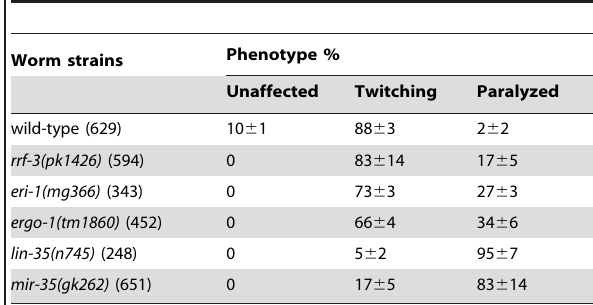
Table 3. The RNAi hypersensitivity of mir-35-41 ( gk26 2) is comparable to that of lin-35(n745) .